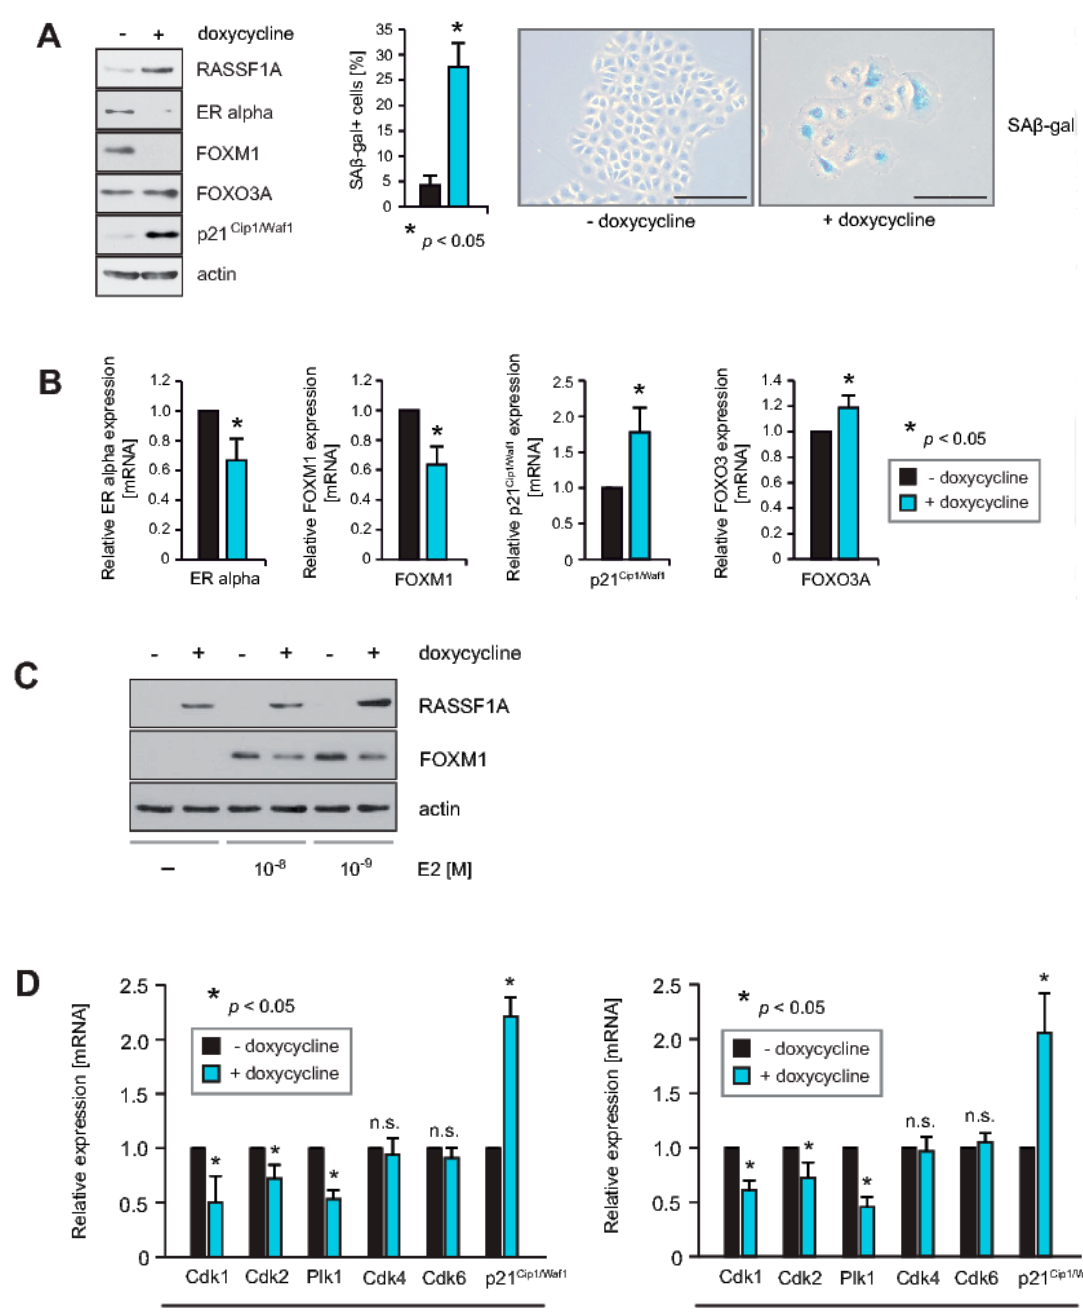
Figure 1. RASSF1A causes decreased expression of FOXM1 and ER α , and induces senescence. ( A ) Induction of RASSF1A expression in conditional RASSF1A MCF7 cells was achieved by culturing cells in the presence of 1 µ g / mL doxycycline. Cell extracts from induced and non-induced conditional RASSF1A cells were prepared 48 h after doxycycline administration and were analyzed by immunoblotting using the indicated antibodies. Actin serves as a loading control (left panel). Densitometric quantification of the bands FOXO3A—doxycycline: 100 versus FOXO3A + doxycycline: 173; detailed information about the western blots are given at Figure S1. Conditional RASSF1A cells were plated at equal densities and grown for 6 days in the presence or absence of doxycycline as indicated. RASSF1A-induced senescence was subsequently monitored by SA β -gal staining (right panel). Bars = 100 µ m. The quantification of senescent cells was achieved by counting (middle panel). Mean values ± s.d. of six independent experiments are shown. p -values < 0.05 are indicated by asterisks. ( B ) RASSF1A downregulates transcription of ER α and FOXM1 but increases the expression